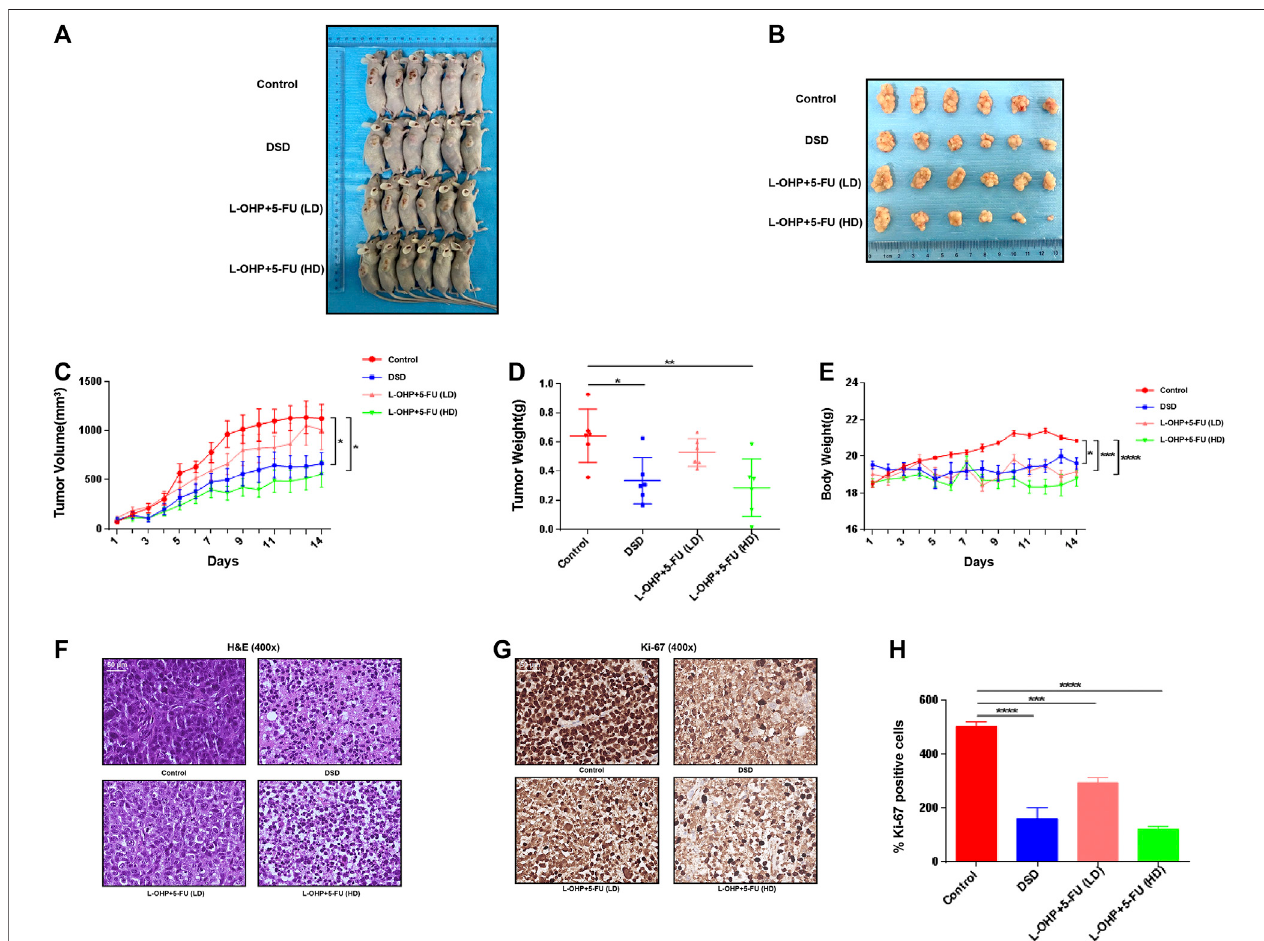
FIGURE4| DSDsuppresseddevelopmentofthexenograftedGCtumorsonmice. (A) ThetumormassesinoculatedonBALB/cmicewerecarefullycheckeddaily with the naked eye. The photos showed the mice bearing tumors on day 14. (B) The tumors were resected on day 14. (C) The tumor volumes were measured and calculated once daily for 14 consecutive days. (D) The resected tumors from different treatment groups were weighted on day 14. (E) The body weight of micewere measured and documented once daily. (F – G) H&E staining and immunohistochemical staining of Ki-67 protein in vital areas of tumor slicescollected from different groups of mice. (H) Statistical analysis of the positive ratio of Ki-67 staining. * p < 0.05, *** p < 0.001 and **** p < 0.0001 based on the Student ’ s t